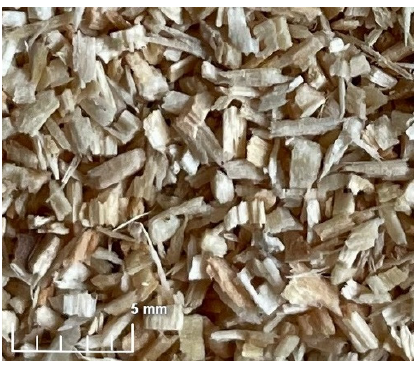
Figure 1. Wood particles used as a filler for PUR foams.